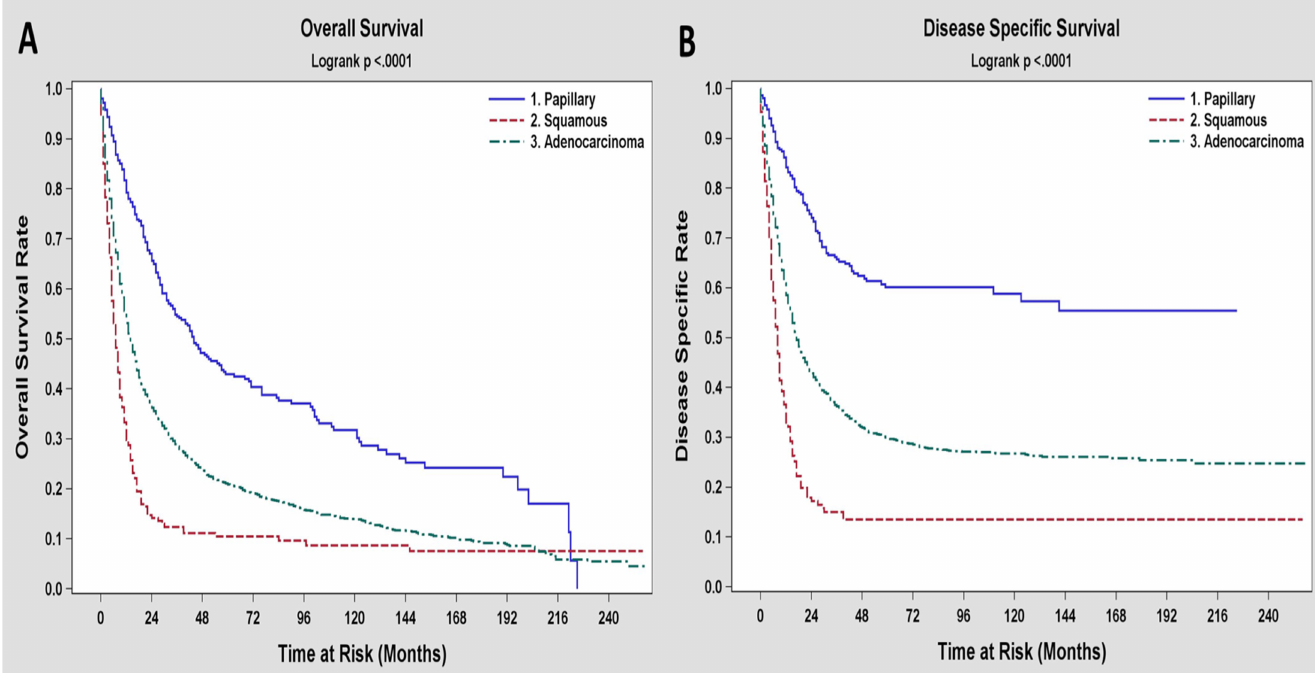
Fig 1. Kaplan-Meier curves for overall survival (A) and disease specific survival (B) based on the three histologic types of gallbladder carcinoma.